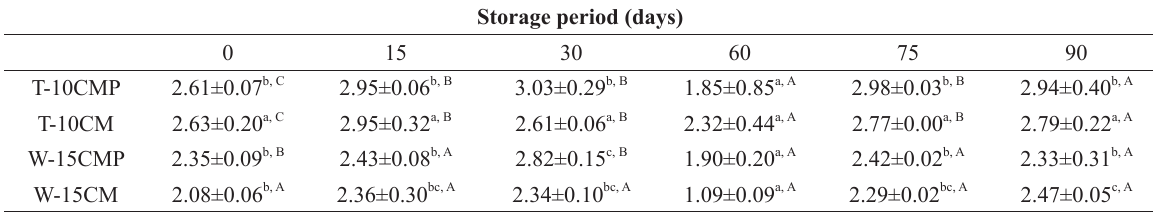
Changes in APCs 1 (log cfu/g) of snacks during storage